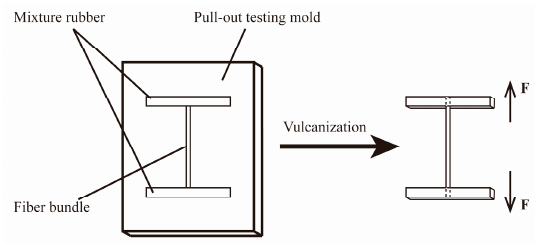
Figure 2. The schematic diagram of the pull-out force test.